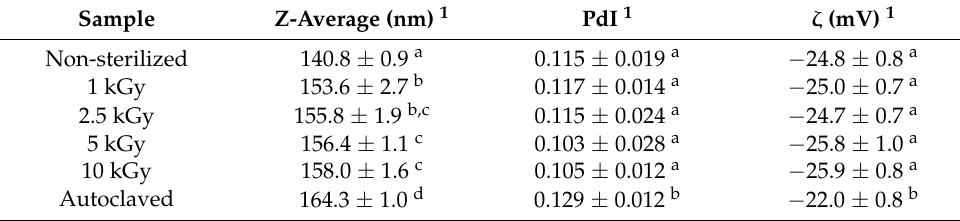
Table 1. Hydrodynamic size or Z-average (d.nm), polydispersity index (PdI), and zeta potential ( ζ , mV).